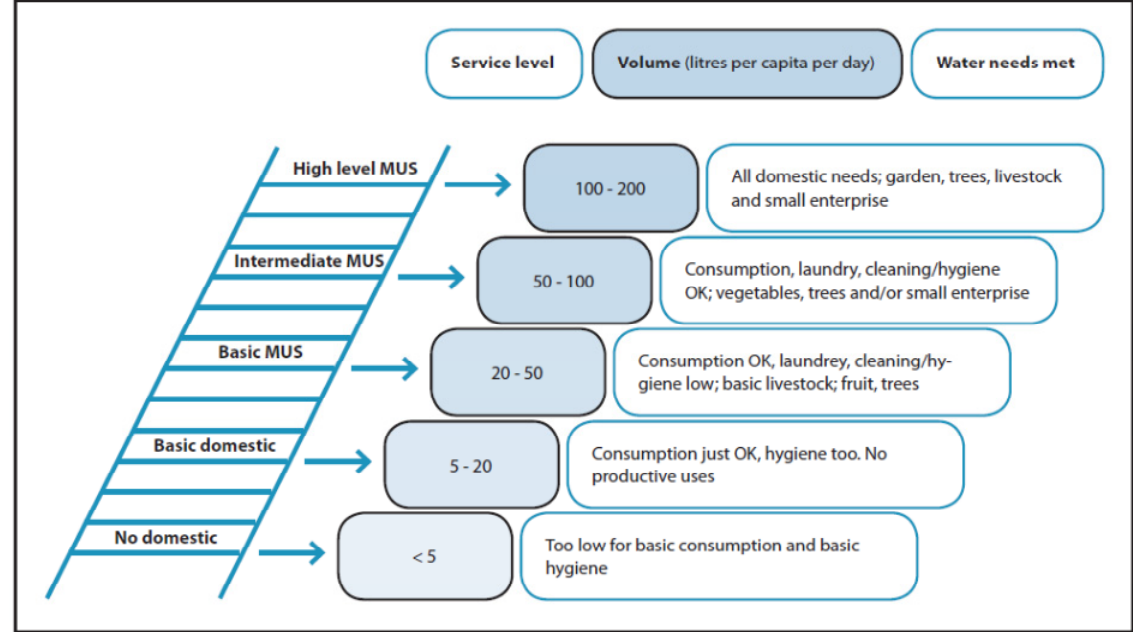
Figure 3. A multiple-use services framework (Adapted from [35] with